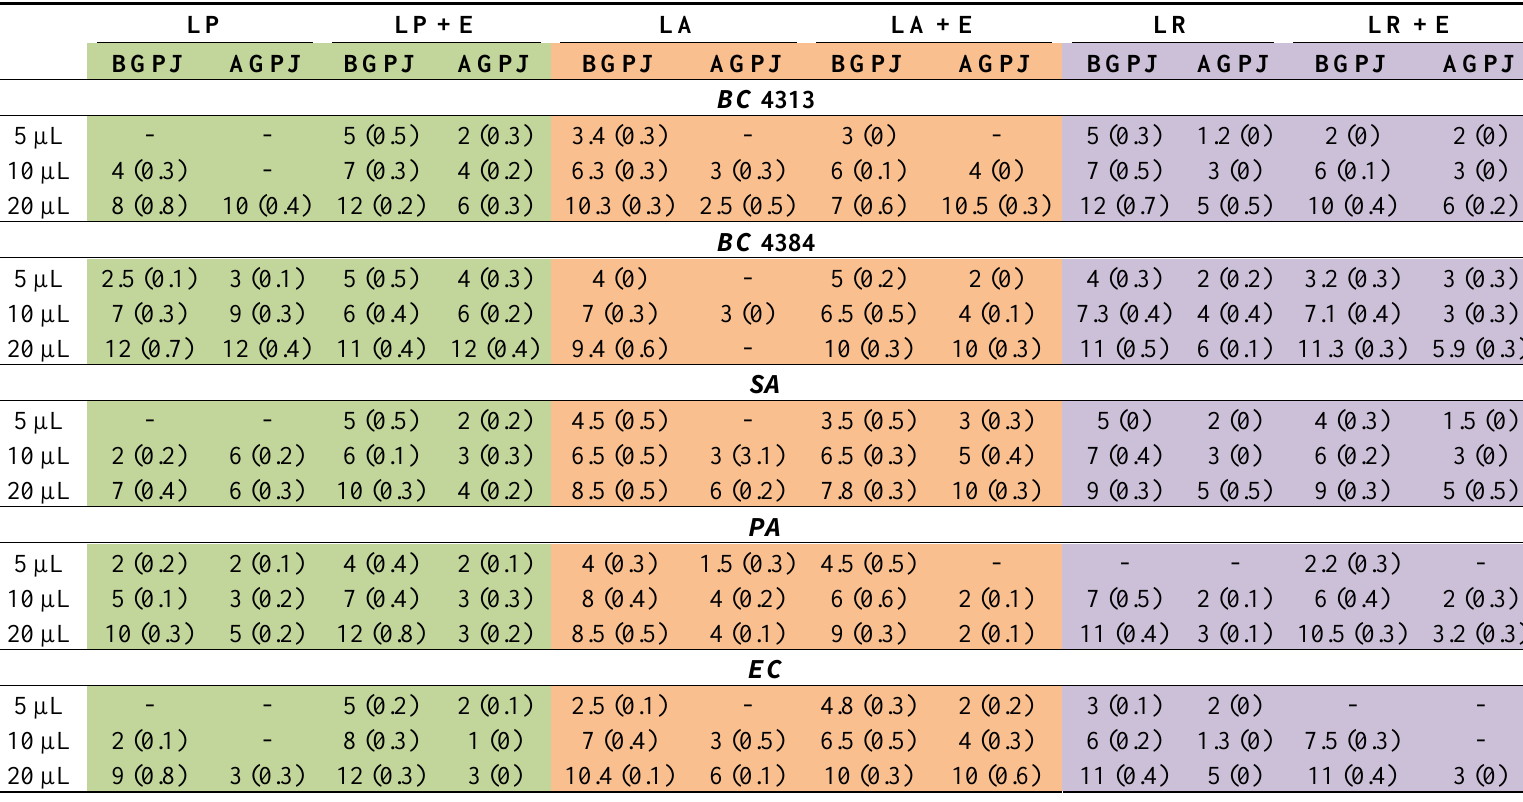
Table 4. Antimicrobial activity (evaluated through the inhibition halo test) of the filtered supernatant of MRS and MRS + E. sativa after the growth of L. acidophilus (LA, orange), L. plantarum (LP, green) and L. rhamnosus (LR, purple) before (BGPJ) and after (AGPJ) the in vitro gastro-intestinal transit. The results are reported as mm of halo (±standard deviation) and are the mean of three independent